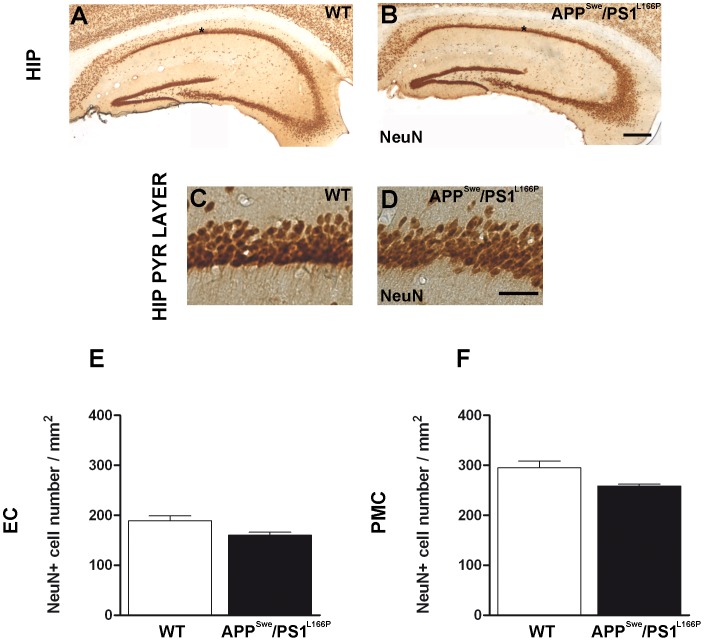
Twelve-month-old APPSwe/PS1L166P mice do not reveal a reduction in neuronal cell number.Representative images of coronal hippocampal sections of 12 month old wild-type (A; C) and APPSwe/PS1L166P (B; D) mice stained with the neuron-selective NeuN antibody. The images show that there is no evident cell loss at 12 months of age in the hippocampus of APPSwe/PS1L166P mice. Calibration bars, 250 µm (A; B); 25 µm (C; D). The analysis of NeuN immunostaining in entorhinal (E) and primary motor (F) cortex of wild-type and APPSwe/PS1L166P mice revealed that also in these structures there is no significant loss of cells at 12 months of age (n = 5 in each group, three sections per mouse, three pictures per sections, Student’s t-test). Error bars represent SEM. (HIP, hippocampus; HIP PYR LAYER; hippocampal pyramidal layer; EC, entorhinal cortex; PMC, primary motor cortex).